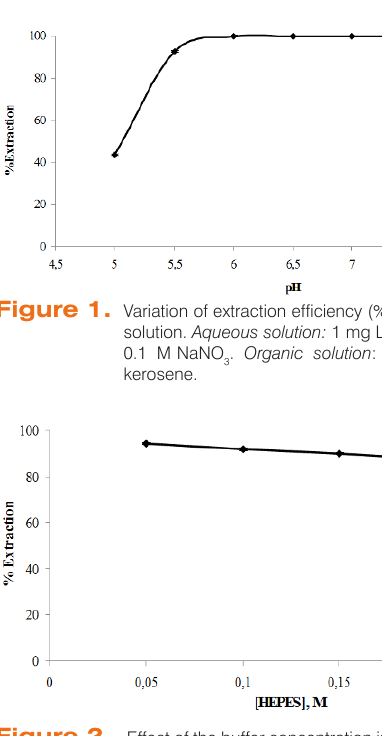
Figure 2. Effect of the buffer concentration in aqueous solution on the extraction. Aqueous solution: 1 mg L -1 Cd 2+ , 0.1 M NaNO . Organic solution : 0.1 M Cyanex 272 in kerosene. 3